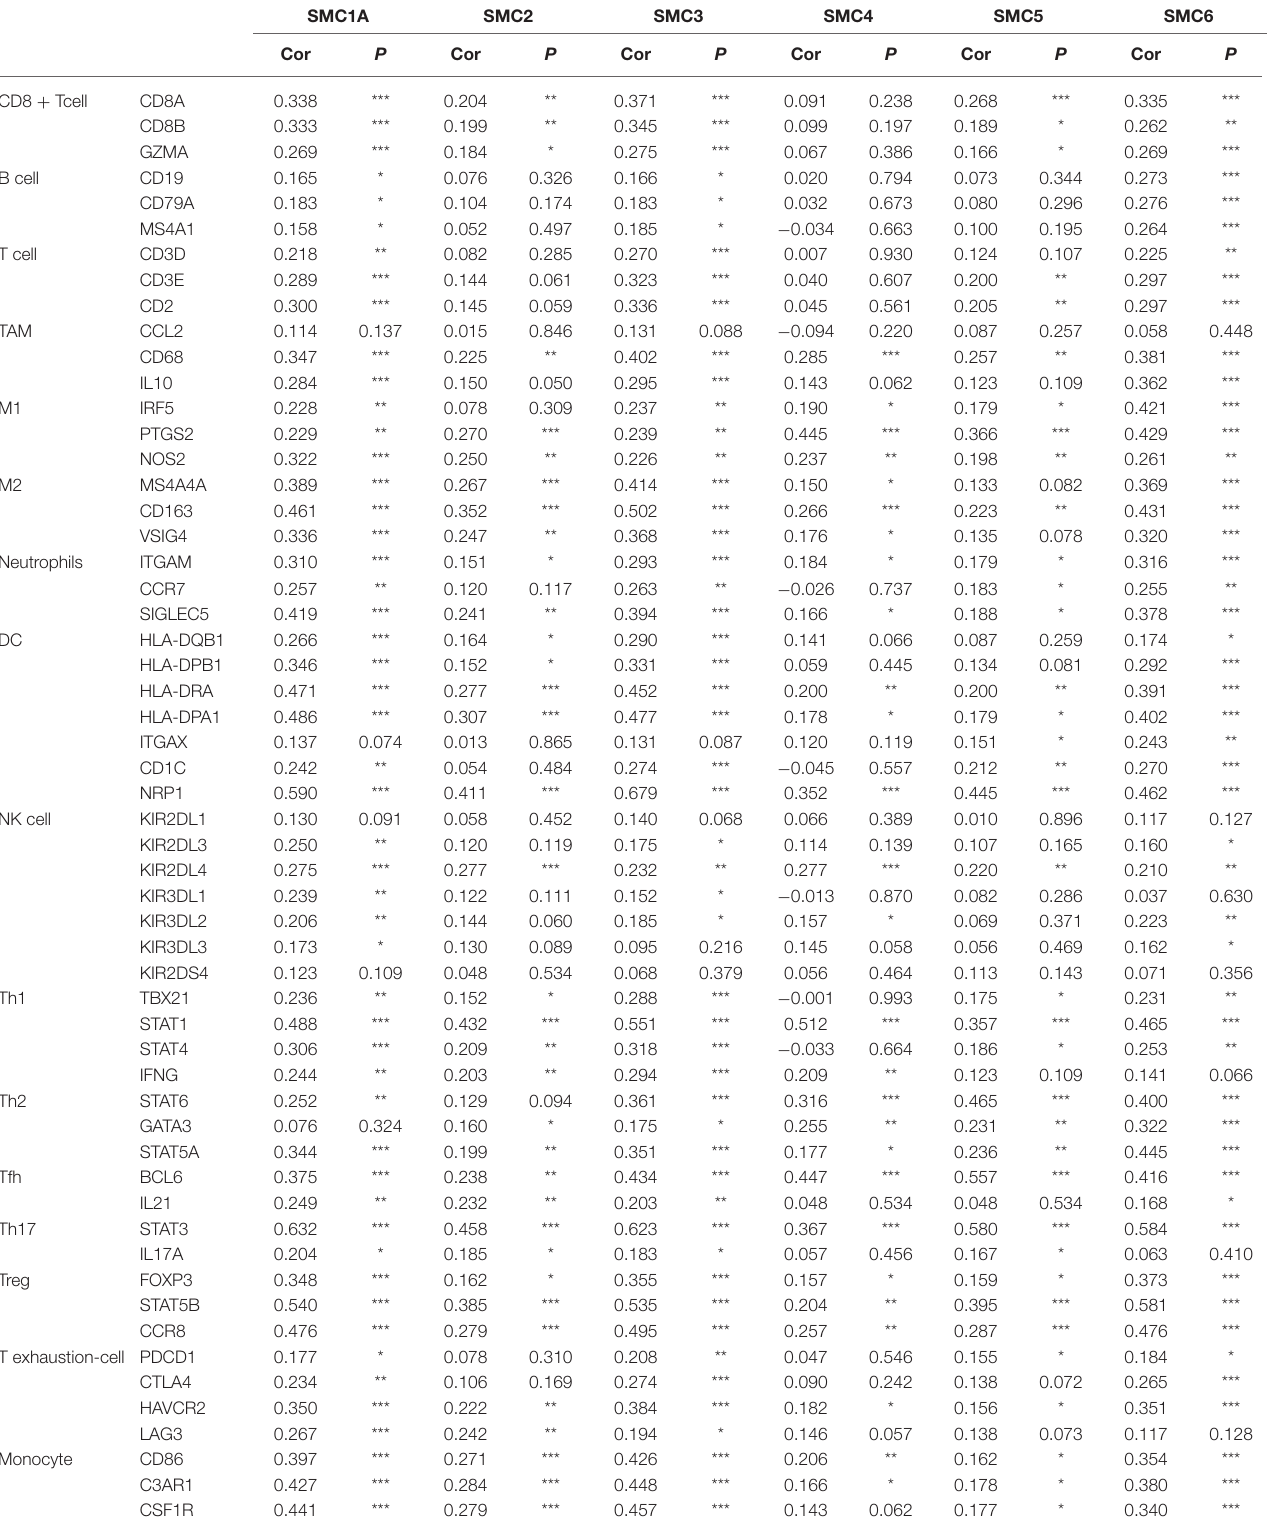
TABLE 2 | The association between the expression of SMC family members and the markers of immune cells.